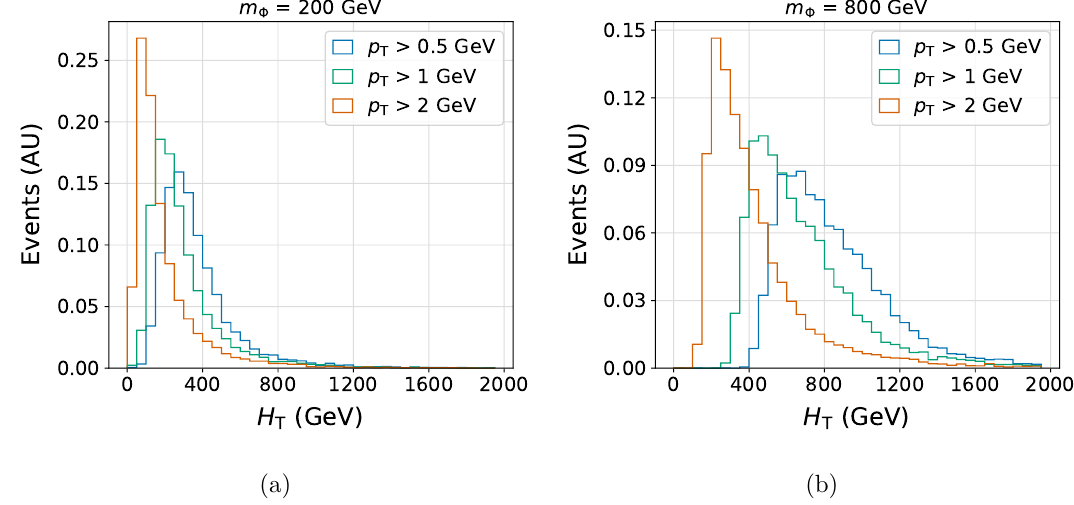
Figure 5. H T of charged particles passing the specified track p T threshold, for mediators of mass 200 GeV (a) and 800 GeV